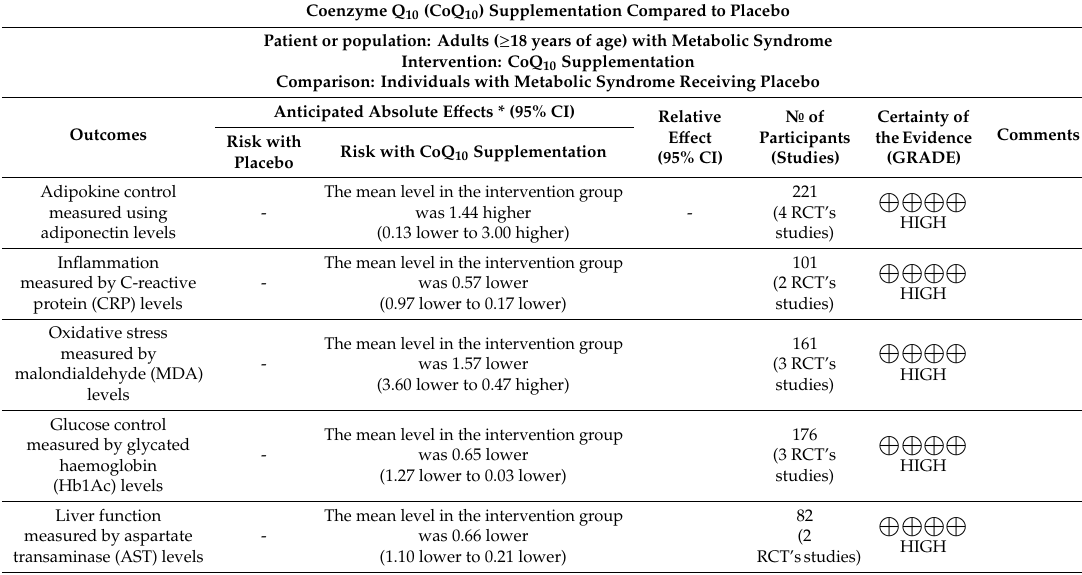
Figure 6. The effect of coenzyme Q 10 (CoQ 10 ) supplementation on liver function measured using alanine transaminase (ALT) and aspartate transaminase (AST) in individuals with non-alcoholic fatty liver disease (NAFLD). Table 2. Summary of findings.